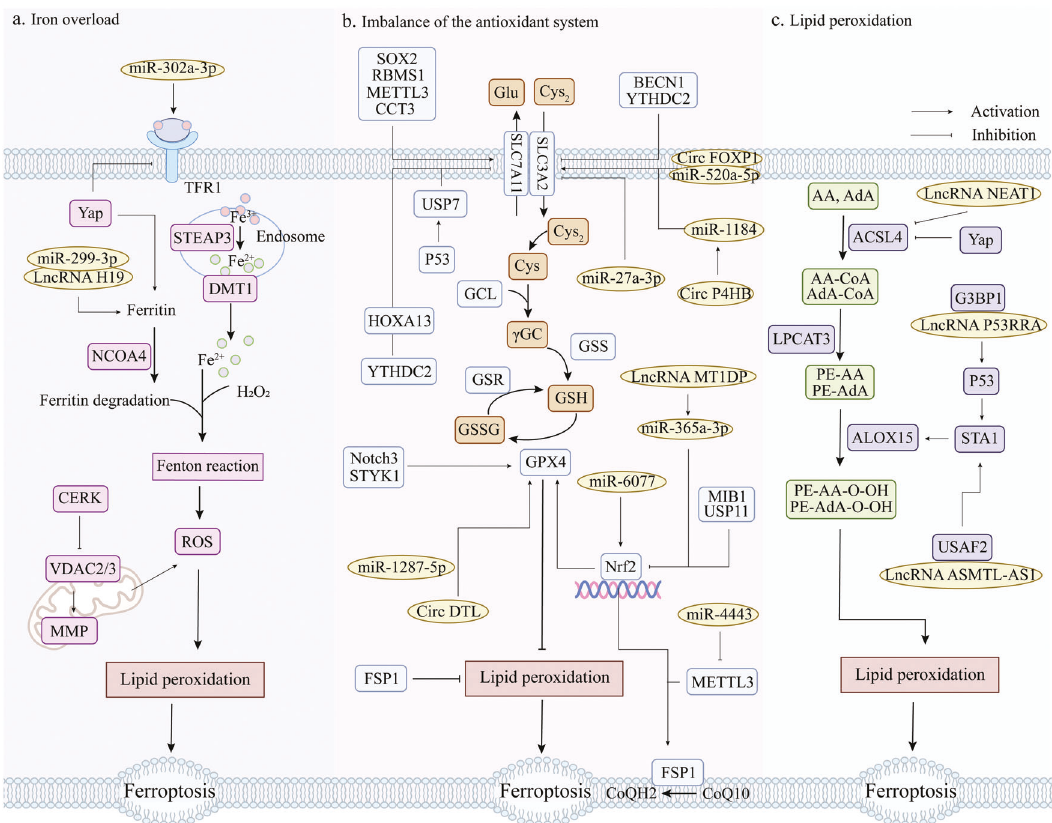
Fig. 2 Relevant targets and their interactions for targeting ferroptosis for lung cancer therapy. GPX4 glutathione peroxidase 4, SLC3A2 solute carrier family 3, member 2, SLC7A11 solute carrier family 7 (L-type amino acid transporter), member 11, RBMS1 RNA-binding protein, SOX2 stem cell transcriptional factor, AKR1B1 aldo-keto reductase family 1 member B1, STAT3 activator of transcription 3, METTL3 methyltransferase-like 3, CCT3 chaperonin containing TCP1 subunit 3, Nrf2 nuclear factor erythroid 2-related factor 2, GCL glutamate- cysteine ligase, γ GC gamma-glutamylcysteine, MIB1 E3 ubiquitin ligase, p53 tumor suppressor protein, SAT1 spermidine/spermine N1- acetyltransferase 1, GLS2 glutaminase 2, FSP1 ferroptosis inhibitor protein 1, NFS1 NFS1 cysteine desulfurase, STYK1 Serine-threonine tyrosine kinase 1, LSH Lymph-speci fi c helicase, GINS4 a member of GINS family proteins, Yap Yes associated transcriptional regulator, TFR1 transferrin receptor, FTH ferritin heavy chain, FTL ferritin light chain, BECN1 ecombinant human autophagy effector protein, USP7 ubiquitin- speci fi c processing protease 7, USP11 ubiquitin-speci fi c processing protease 11, CRL4 DCAF8 cullin-RING E3 ligase complex, YTHDC2 N6- methyladenosine (m6A) RNA binding protein, A20 ubiquitin-regulated enzyme, SENP1 Small ubiquitin-like modi fi er speci fi c protease 1, Notch3 the third subtype of Notch family, PRDX6 peroxiredoxin 6, CERK ceramide kinaseCeramide kinase, VDAC voltage-dependent anion- selective channel, MMP mitochondrial membrane potential, miRNA MicroRNA, circRNA Circular RNA, lncRNA Long non-coding RNA, METTL3 methyltransferase-like 3, FABP3 fatty acid binding protein 3, ELAVL1 RNA-binding protein, CBS cystathionine β -synthase, G3BP1 Ras GTPase activating protein binding protein 1. lung cancer, and has great signi fi cance in the research of GPX4 exerts a negative effect on ferroptosis in a variety of cancer ferroptosis in lung cancer. cells. For example, when GPX4 is overexpressed, HT-1080 cells are resistant to RSL3, whereas the knockdown of GPX4 makes HT-1080 cells sensitive to RSL3 [53]. In the study of lung cancer, the immunohistochemical staining results of clinical lung adenocarci- noma samples compared with normal alveolar epithelial cells and bronchial epithelial cells showed that GPX4 was strongly positive in lung adenocarcinoma tissues. And by targeting GPX4 can induce ferroptosis in lung adenocarcinoma cells and reverse their resistance to epidermal growth factor receptor-tyrosine kinase inhibitor (EGFR-TKI) [66]. Meanwhile, targeting GPX4 can also promote lapatinib (Lap) -induced ferroptosis in drug-resistant non- small cell lung cancer cells [67]. In addition to lapatinib, GPX4 was also positively correlated with chemoresistance to anticancer drugs L-685458, palbociclib, and topotecan [68, 69]. At the same time, inhibition of GPX4 expression can partially reduce the radiation resistance of lung cancer cells and promote the ef fi cacy of radiotherapy [70]. In conclusion, GPX4 can affect the develop- ment of lung cancer by regulating ferroptosis. On the other hand, it is also related to the drug resistance and radiation resistance of Cell Death Discovery (2023)